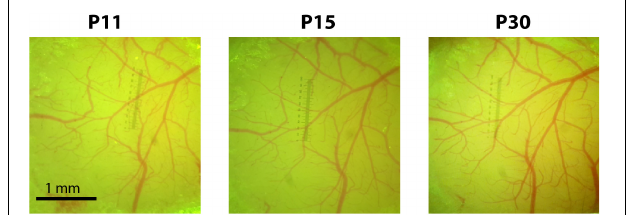
FIGURE 2 | Cranial windows implanted at P10 remain optically transparent for weeks. Photographs of the cranial window at P11, P15, and P30 for a representative mouse injected with rAAV-GCaMP6s at